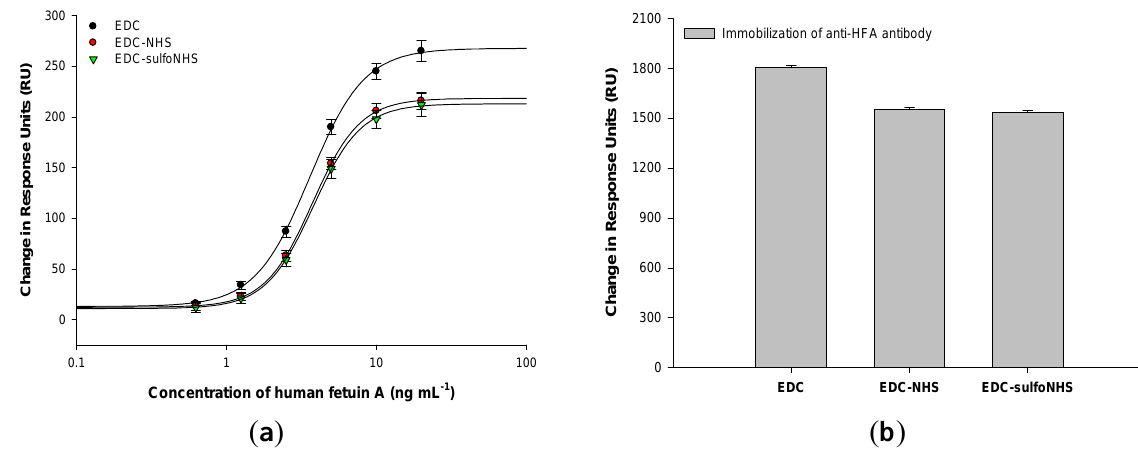
Figure 2. ( a ) Surface plasmon resonance (SPR)-based anti-human fetuin A (HFA) immunoassay using various EDC-based strategies for crosslinking anti-HFA antibodies to APTES-functionalized SPR gold chips; ( b ) SPR response units corresponding to the binding of capture anti-HFA antibodies by the various strategies. The values are average of four repeats in different flow cells. The errors bars represent standard